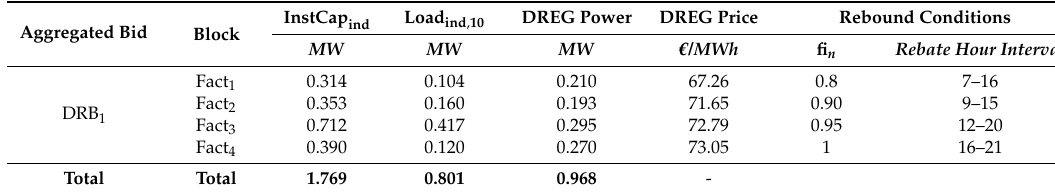
Table 5. Industrial area flexibility at hour 10.